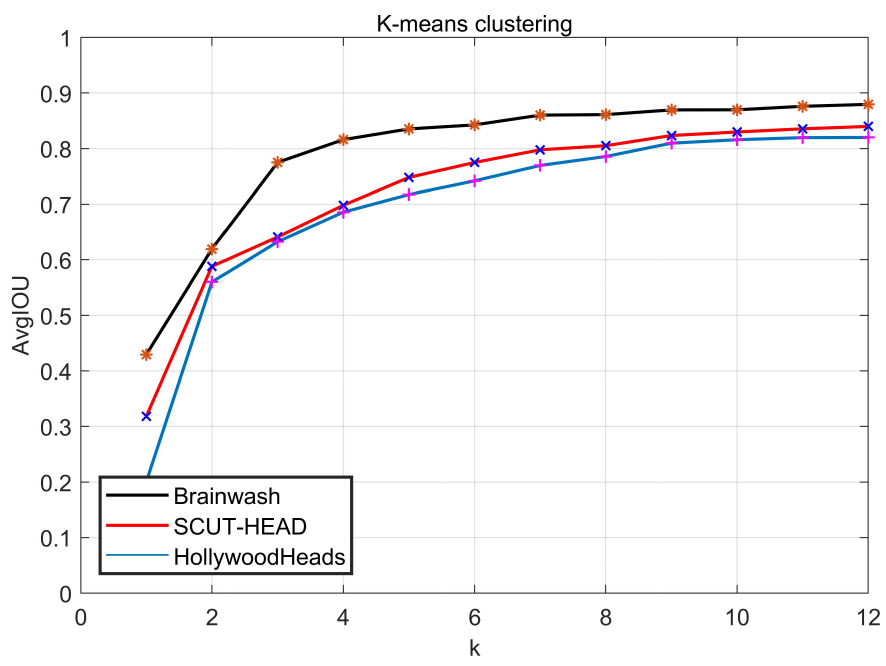
Figure 7. K-means clustering analysis results on the Brainwash, Hollywoodheads, and SCUT- HEAD